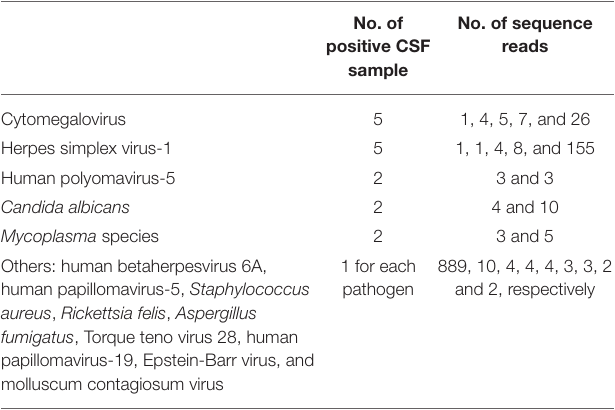
TABLE 3 | Pathogens unexpectedly reported by the mNGS.